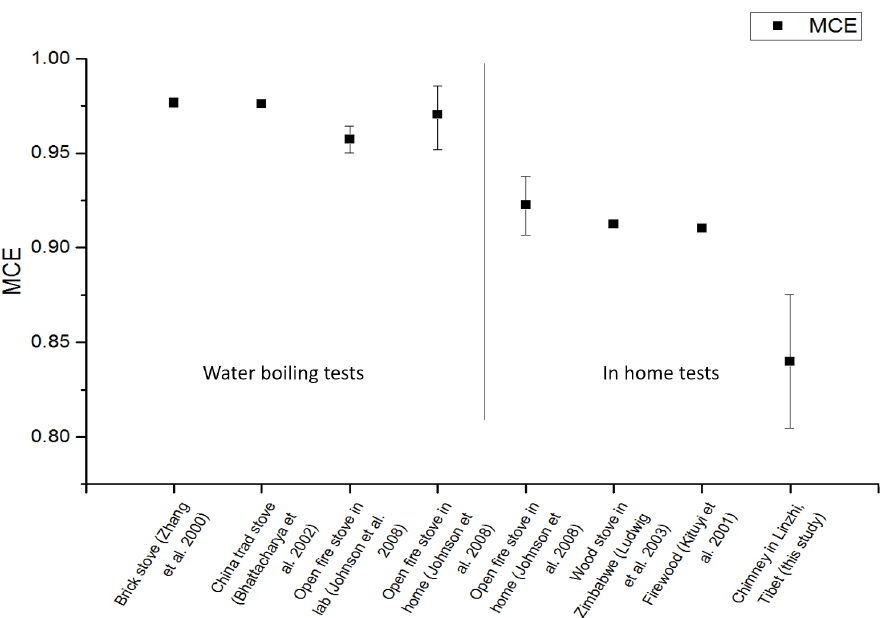
Figure 7. The MCE comparison.